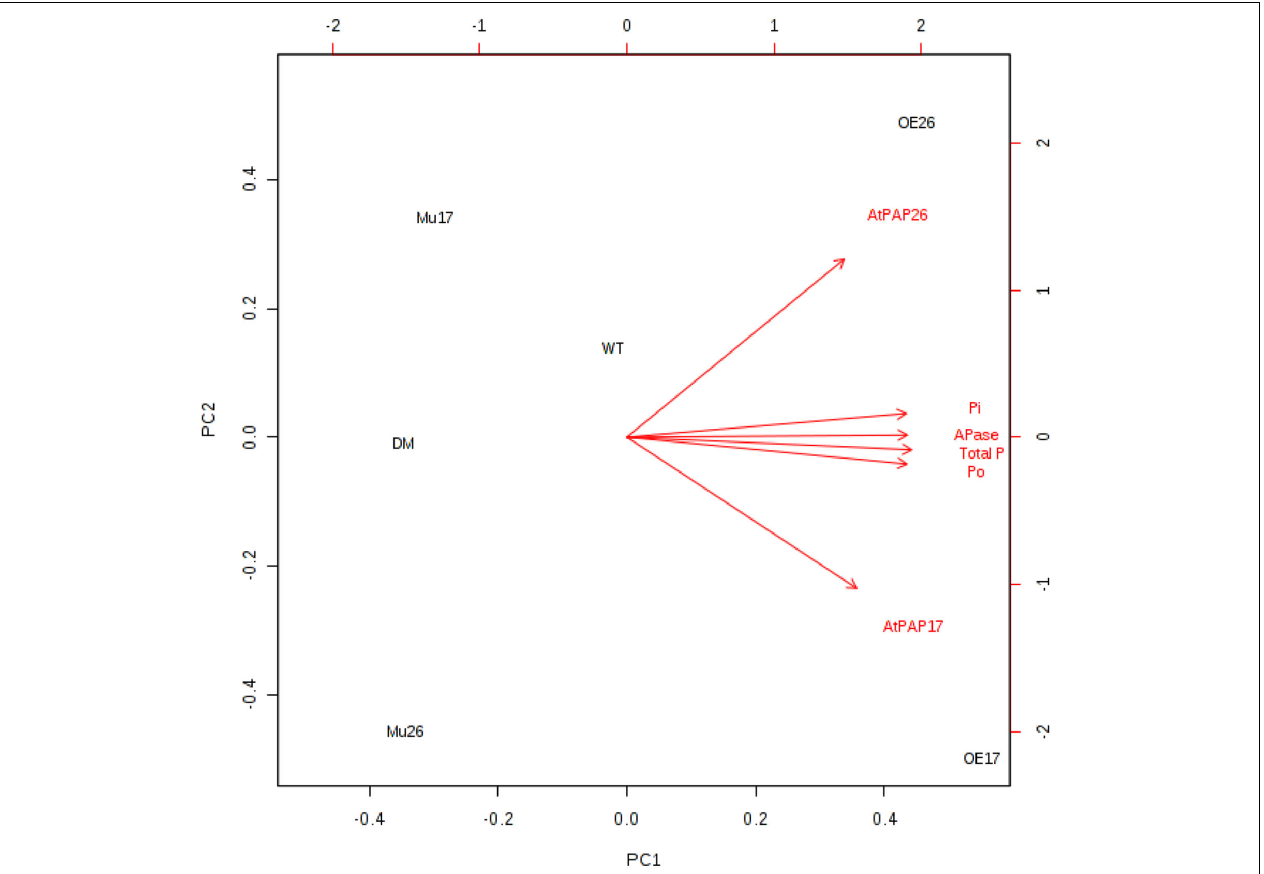
FIGURE 6 | Biplot analysis of the expression level of AtPAP17 and AtPAP26 genes, APase activity, total phosphate, inorganic (Pi), and organic phosphate (Po) content in the examined genotypes to show the relationship at 150 mM NaCl stress. Wild type (WT), overexpress (OE), single mutant (Mu), and double mutant (DM) genotypes of Arabidopsis thaliana purple acid phosphatase 17 ( AtPAP17 ) and 26 ( AtPAP26 )